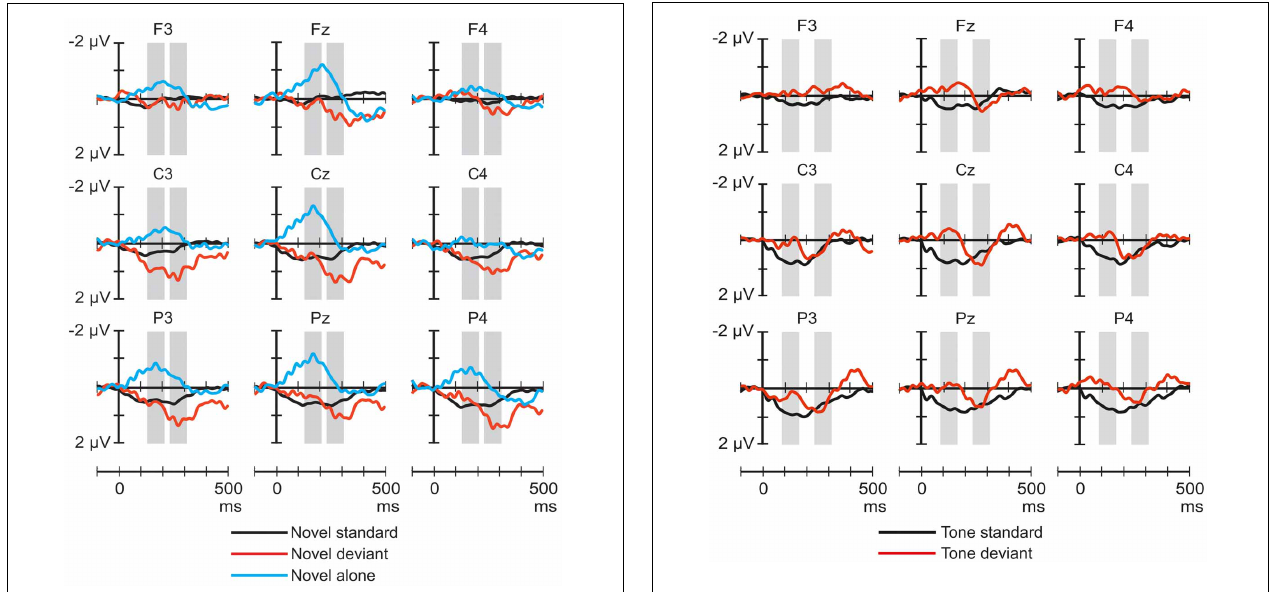
FIGURE 1 | Group-average ( n = 23) ERP responses elicited by the novel sounds in the novel-deviant (red line), novel-standard (black), and novel-alone (blue) conditions at frontal, central, and parietal scalp locations. Amplitude measurement windows are indicated by gray bars.